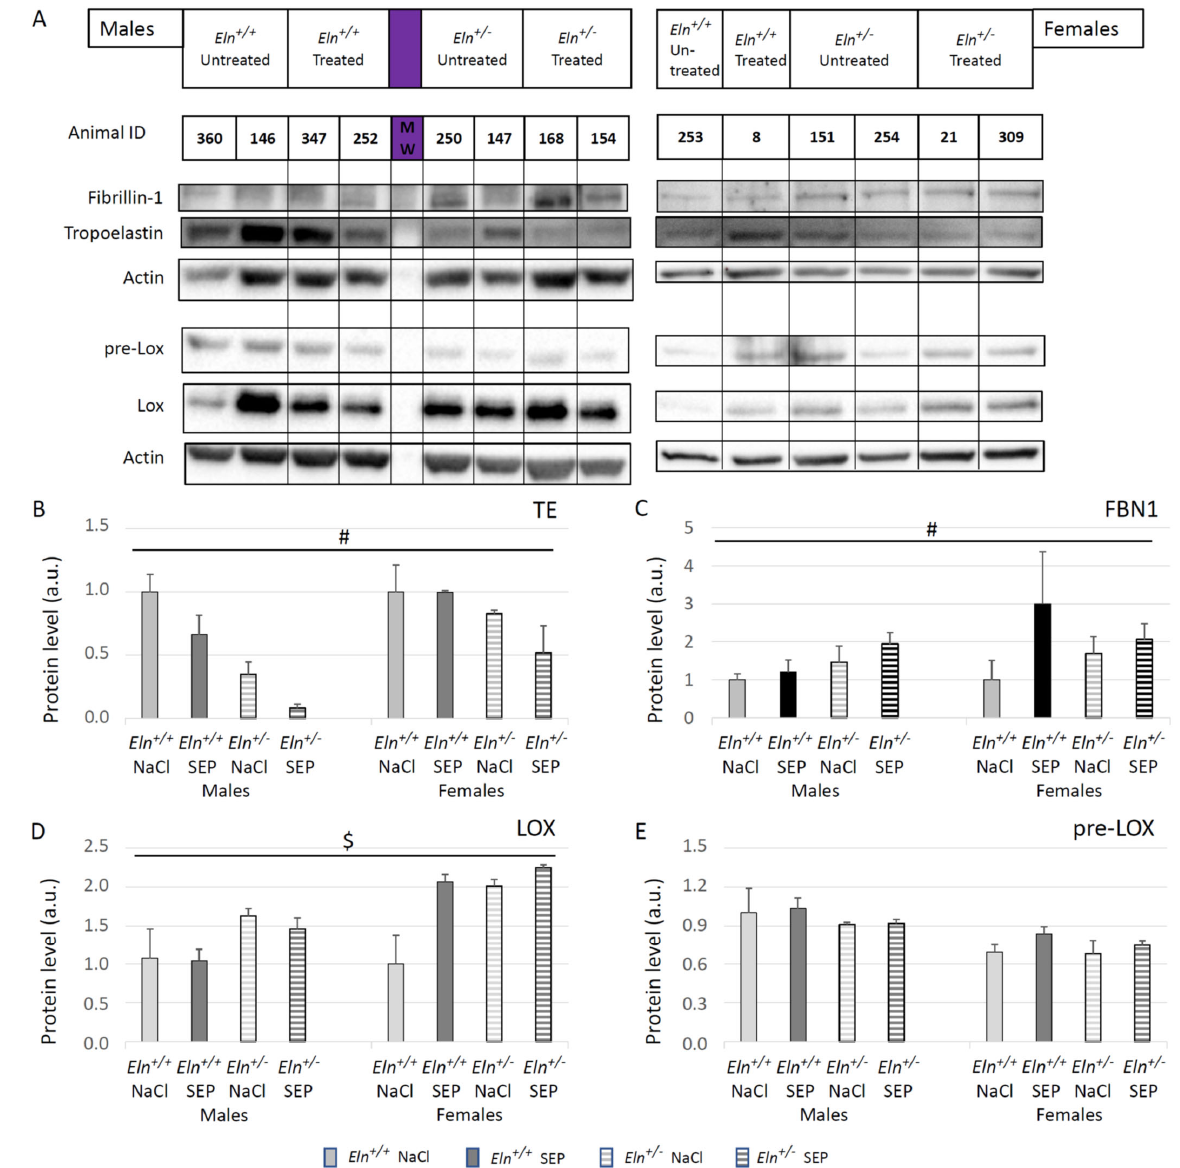
Figure 10. Western blotting of descending thoracic aorta extracts from untreated or SEP ‐ treated mice. ( A ) Representative Western blot bands for the proteins of interest in each group. Semi ‐ quantitative analysis of the protein levels was performed by band densitometry for: ( B ) tropoelastin (TE), ( C ) fibrillin ‐ 1 (FBN1), ( D ) lysyl oxidase (LOX, 30kDa), ( E ) immature lysyl oxidase (pre ‐ LOX, 50kDa). # general significant difference between untreated and SEP ‐ treated mice (three ‐ way ANOVA, p ≤ 0.05). $ significant interaction between sex and treatment, independently of genotype (three ‐ way ANOVA, p ≤ 0.05), indicating that SEP elevated the protein level in females, not males (post hoc Fisher’s least significant difference (LSD) tests, p ≤ 0.05). Control animals were injected with the same volume of 0.9% NaCl (NaCl). Values are mean ± SEM. n = 5 in each group.